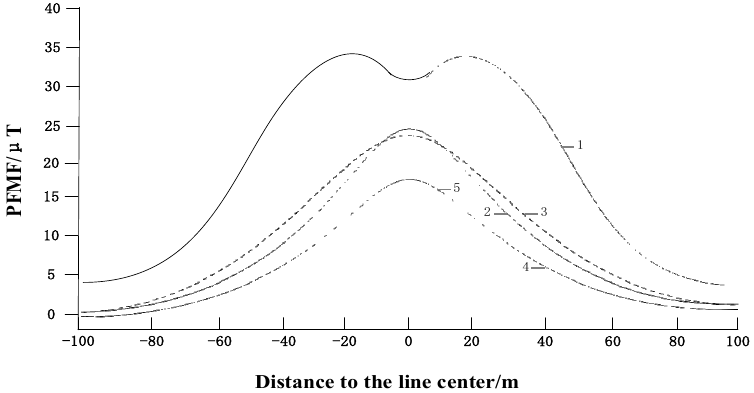
Figure 2. Five PFMF distributions in the UHV overhead transmission line route at 1 m height from the ground. 1—Parallel arrangement of phase conductor; 2—Triangle arrangement of phase conductor; 3—Common-tower double-circuit overhead transmission line; 4—Compact type (10 splits); 5—Compact type (12 splits).